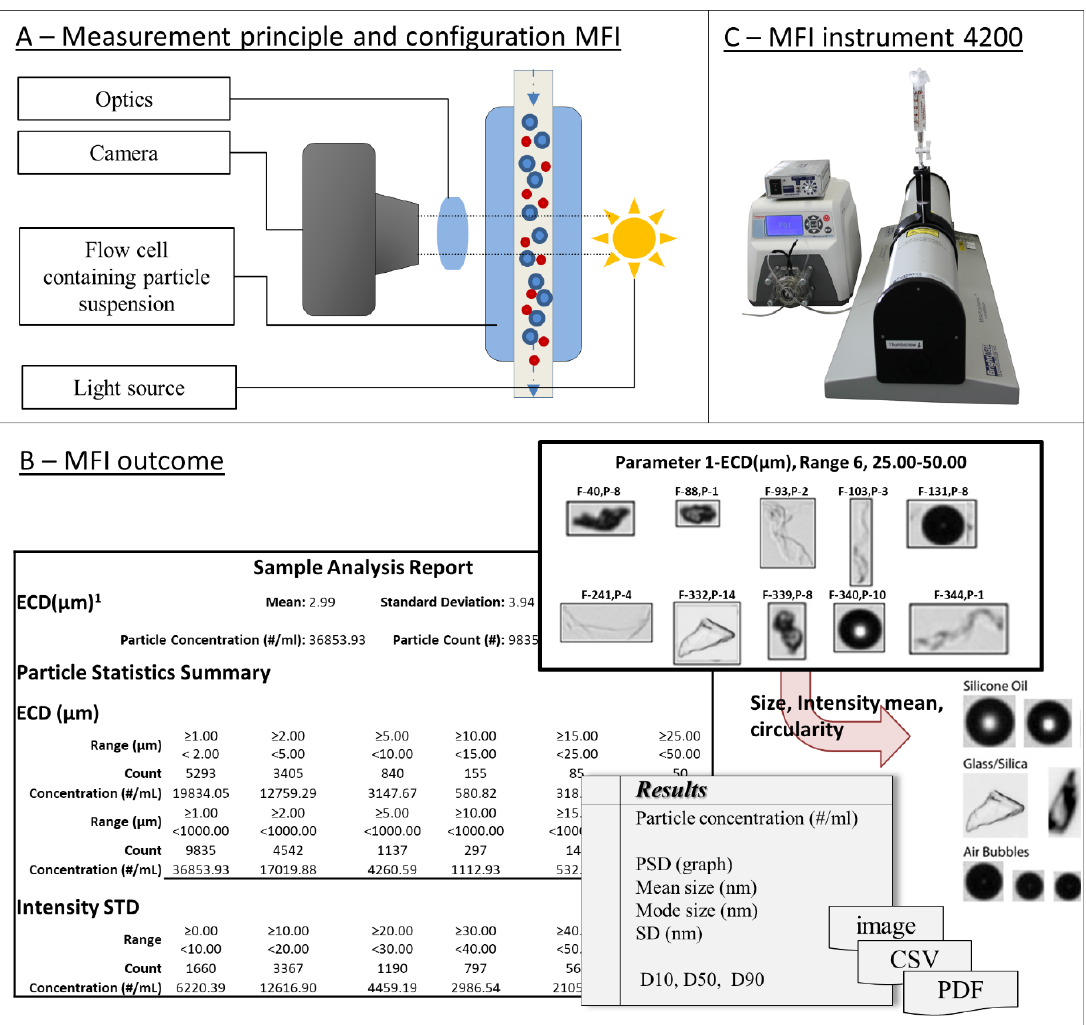
Figure 5. Micro-flow imaging (MFI): instrument, measuring principle, and final result. ( A ) Schematic illustration of the measurement principle of the MFI instruments (Protein Simple). The particle suspension is pumped into the flow cell where the camera captures bright field images as raw data.